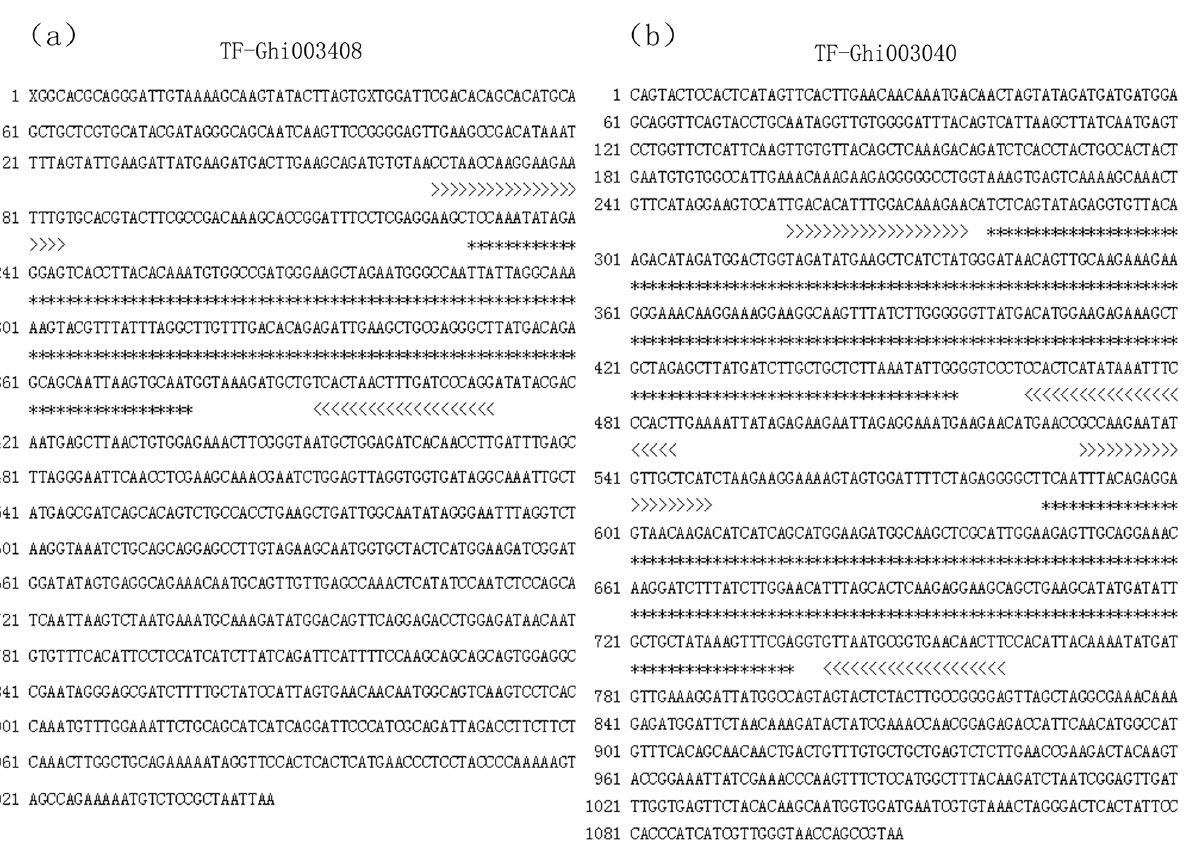
PLOS ONE | DOI:10.1371/journal.pone.0126150 May 6,